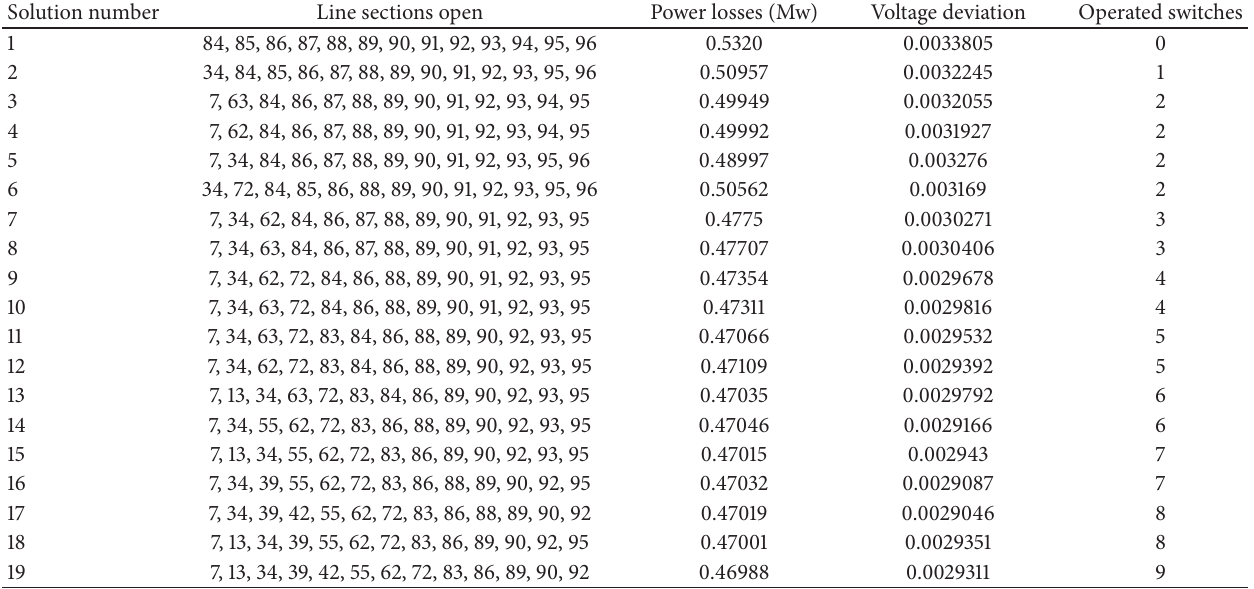
Table 4: Characteristics of the Pareto-optimal solutions in Figure 11.